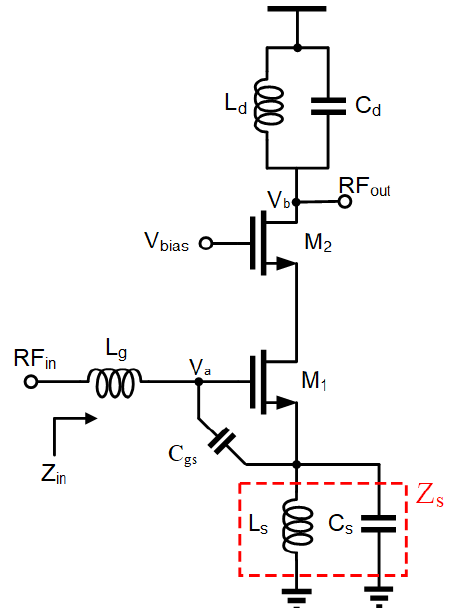
Figure 1. Schematic diagram of the proposed LNA with the notch